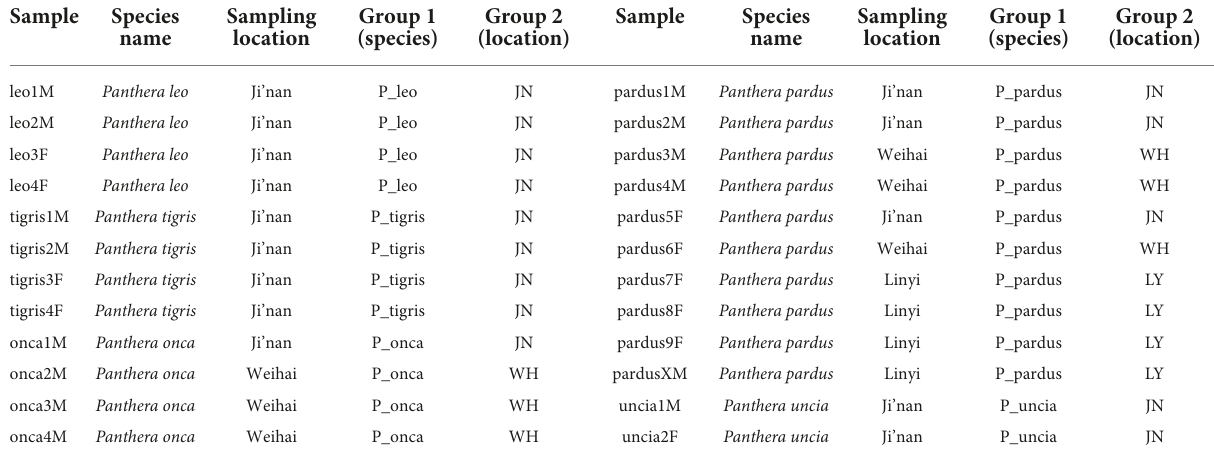
TABLE 1 Sample information and